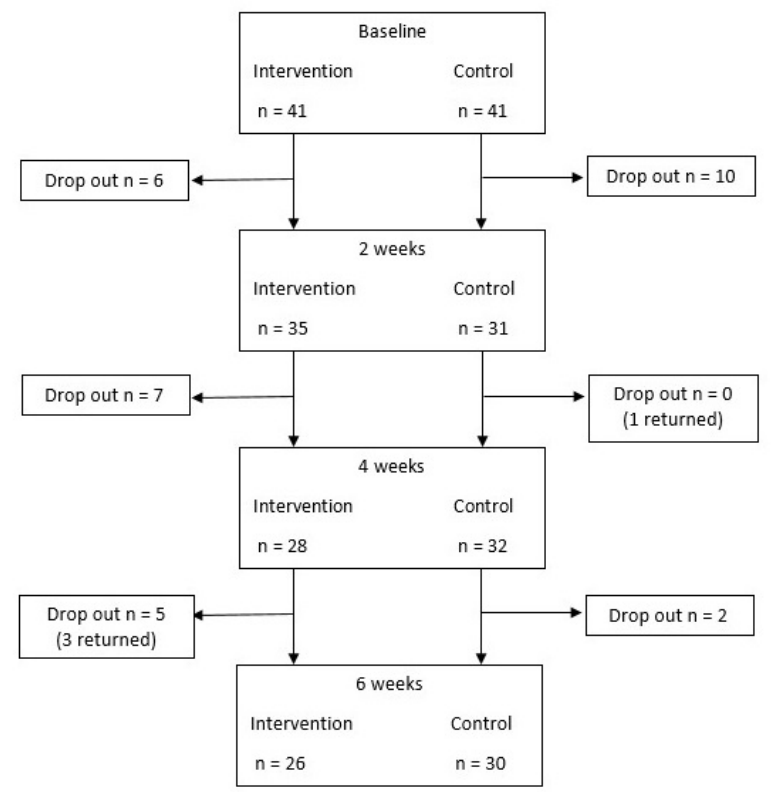
Figure 1. Flow of participants through study.